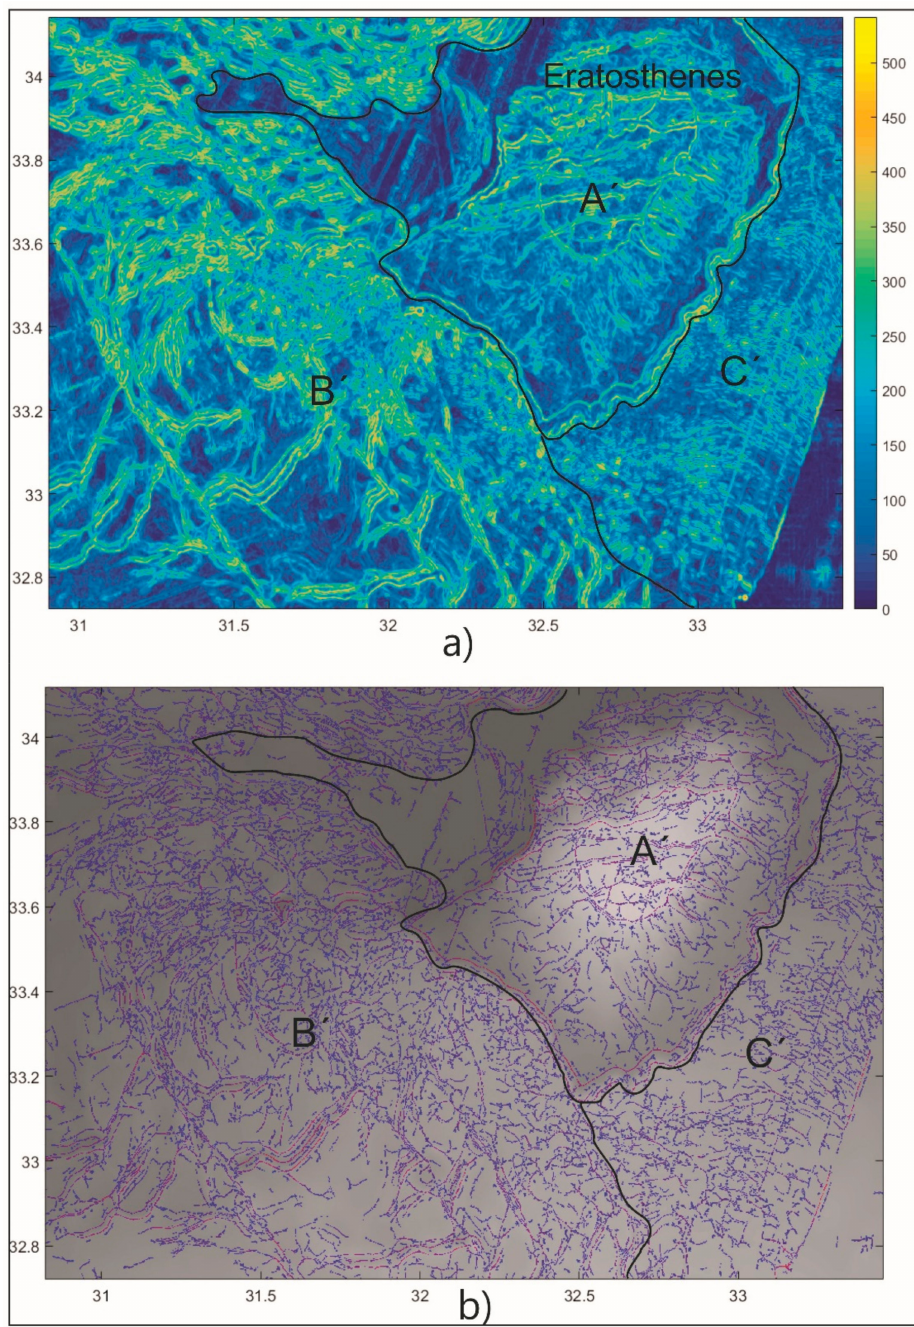
Figure 4. Automatic detection of the seafloor skeleton in the Levantine Basin (east and southwest of the Eratosthenes Seamount) using medium resolution (0.25 arc minutes) data from EMODNet (European Marine Observatory and Data Network) [28] and other sources [29–32]. The reference system is WGS84. ( a ) The output of the multiple filtering approach [34]. Color scale corresponds to the strength of the detection ranging from 0 (blue) to 550 (yellow) with no units. ( b ) The skeleton (medial axes) overlain the bathymetric relief. The red lines correspond to strongly detected linear and curvilinear elements, while the blue lines correspond to weak ones. On the basis of signal texture (strength of the detection, length, direction, and spatial distribution of the lineaments), we divided the area into three sub-regions (A’, B’, and